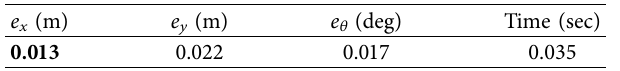
Table 5: The mean value of numerical reading of the EKF (two landmarks and Gaussian